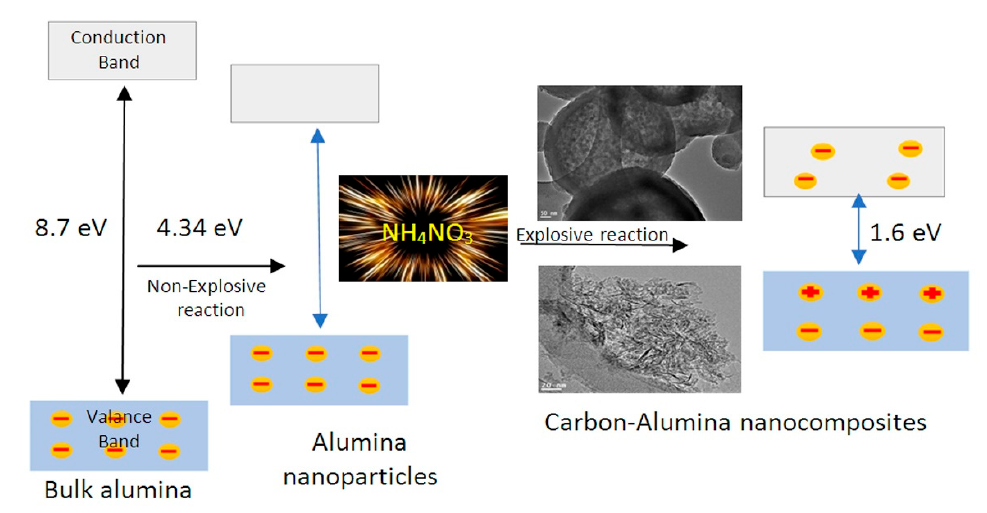
Figure 12. Schematic representation for converting bulk alumina to photo-active alumina.